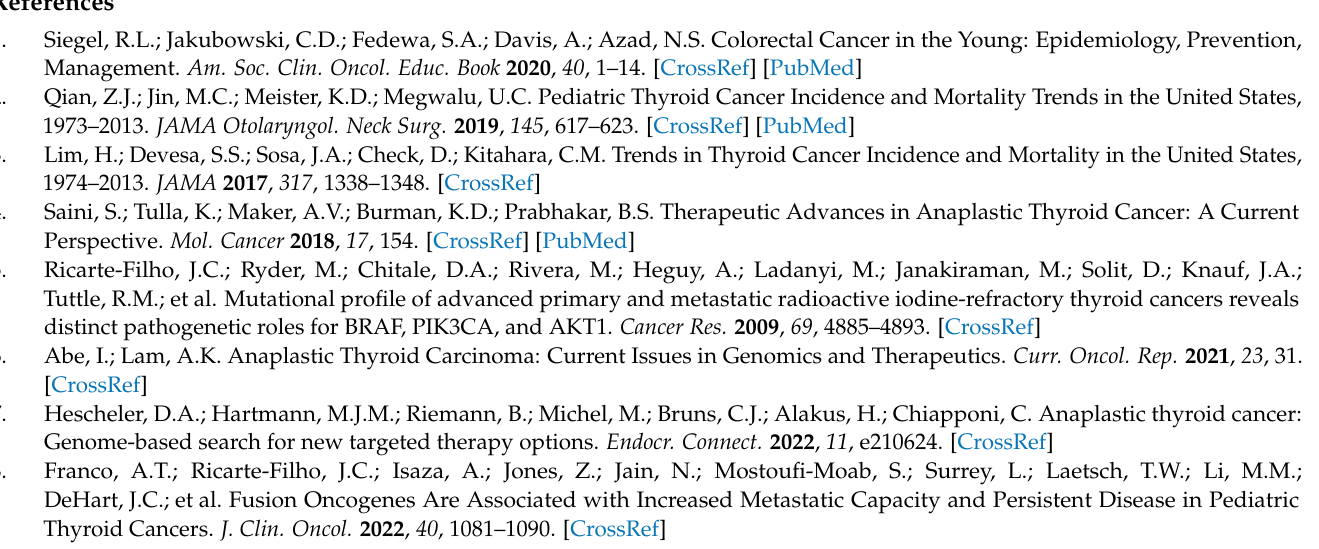
tumors; Figure S2: Braf Recombined DNA gels on cell lines and non-target tissues; Figure S3: